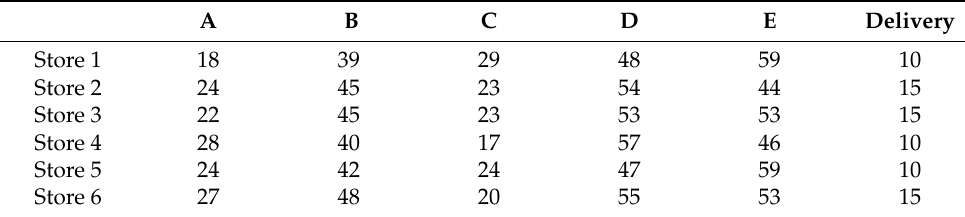
Table 1. Book prices and delivery costs offered by six Internet stores.